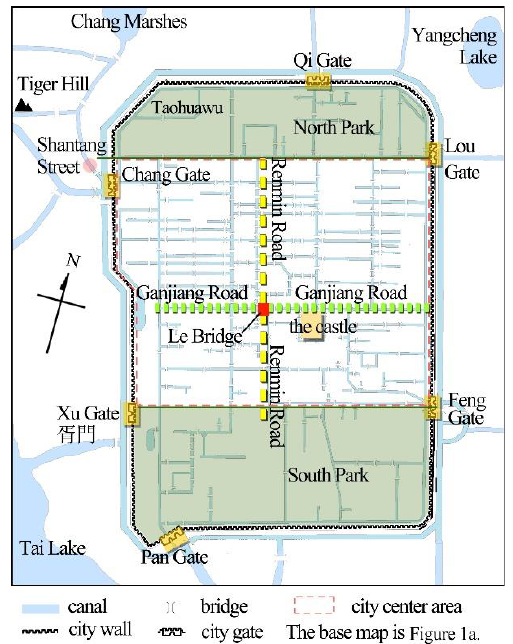
Figure 5. The layout of Suzhou city.